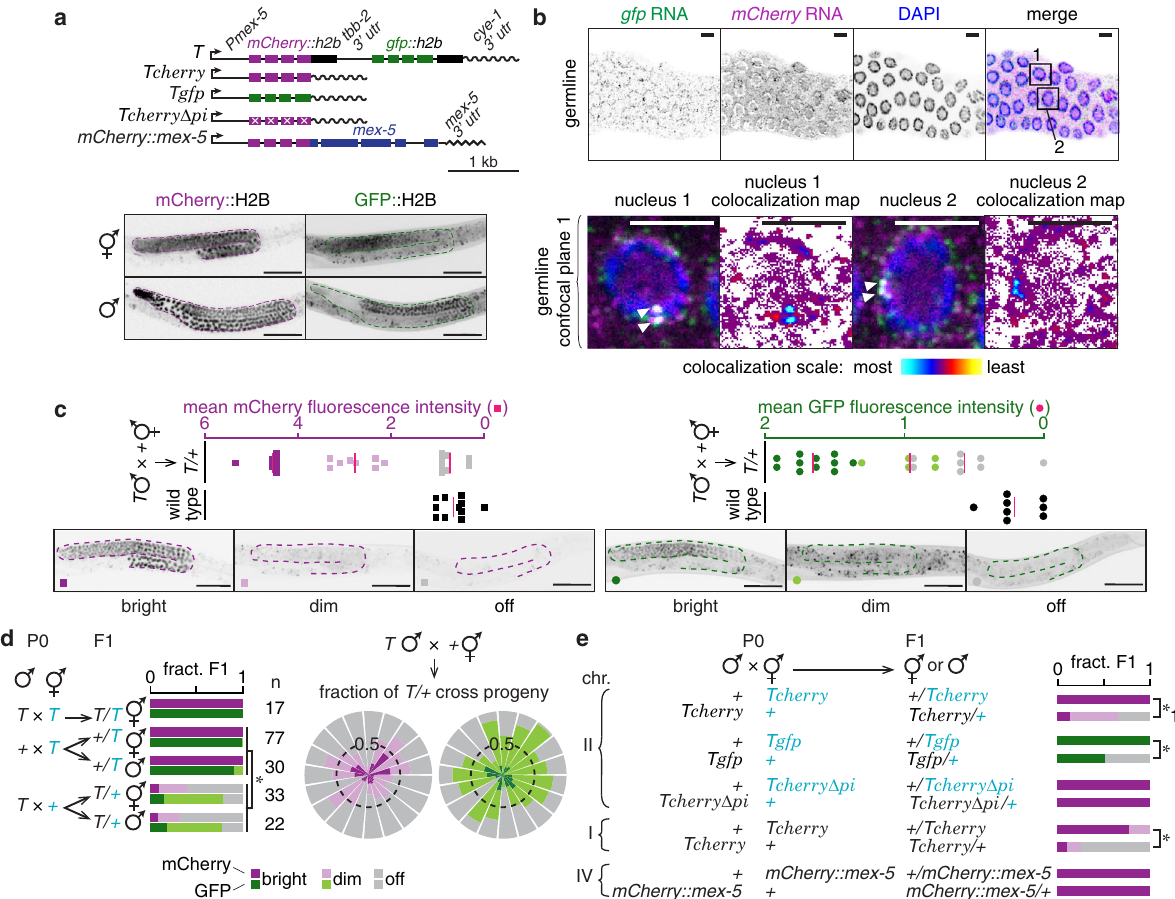
Fig. 1 Mating can disrupt gene expression by initiating RNA silencing. a Schematics of the single-copy transgene Pmex-5::mCherry::h2b::tbb-2 3 ′ utr::gpd-2 operon::gfp::h2b::cye-1 3 ′ utr referred to as T , of independently generated minimal variants expressing only mCherry ( Tcherry ), gfp ( Tgfp ) or mCherry lacking piRNA-binding sites ( Tcherry Δ pi ) and of mCherry fused to endogenous mex-5 coding sequence ( mCherry::mex-5 ) are depicted (top). Germlines (dotted outline) of representative L4-staged hermaphrodites and males showing mCherry (magenta) or GFP (green) expression from T are indicated (bottom). b Single-molecule fl uorescence in situ hybridization (smFISH) of mCherry and gfp in dissected gonads of animals expressing T reveals that mCherry RNA and gfp RNA colocalize as one or two spots (white arrowheads) within nuclei. Representative confocal plane (germline) imaged from a dissected gonad. Additional images are in Supplementary Fig. 1b. Colocalization heat map represents the extent of overlap between pixels corresponding to mCherry RNA and gfp RNA. c Quanti fi cation (top) and representative images (bottom) of the germline (magenta outline and green outline) of hemizygous animals ( T/ + ) scored as having bright, dim, or not detectable (off) mCherry (left) or GFP (right) fl uorescence. Average normalized fl uorescence (red bar) within the germline was calculated for 11 bright, 5 – 8 dim, 8 off (gray), and 7 wild-type (black) L4-staged hermaphrodites. d Cross progeny males and hermaphrodites that inherited T from one or both parents were scored for expression of mCherry and GFP from T (left). Rose plot of independent repeats of mating-induced silencing of T (right). Each segment (mCherry, left and GFP, right) represents independent trials of one to four biological replicates and includes data from experiments depicted in other fi gures within the manuscript (total n = 561 animals). Dashed circles indicate half the fraction of animals scored. e Animals expressing T , Tcherry , Tgfp , Tcherry Δ pi or mCherry fused to the endogenous mex-5 coding sequence ( mCherry::mex-5 ) were mated with non-transgenic animals and resulting cross progeny were scored as having bright (magenta or green), dim (pink or light green), or not detectable (off, gray) levels of mCherry or GFP fl uorescence. Number next to curly brackets refers to the chromosome on which each gene is present. All scored cross progeny were hermaphrodites except in the case of animals with Tcherry on chromosome I, where males were scored to ensure that cross-progeny were scored. In all fi gures, homozygous genotypes are indicated as a single character for simplicity — for example, ‘ T ’ represents homozygous T/T animals, ‘ + ’ represents non- transgenic or wild-type ( + / + ) animals etc. Also see Supplementary Figs. 1 – 7. Asterisks indicate P < 0.05 using χ 2 test. Chromosomes with a dpy marker (blue font) and numbers of animals scored ( n ) are indicated. Scale bars, 50 µ m ( a , c ) and 5 µ m ( b ). Source data are provided as a Source Data fi